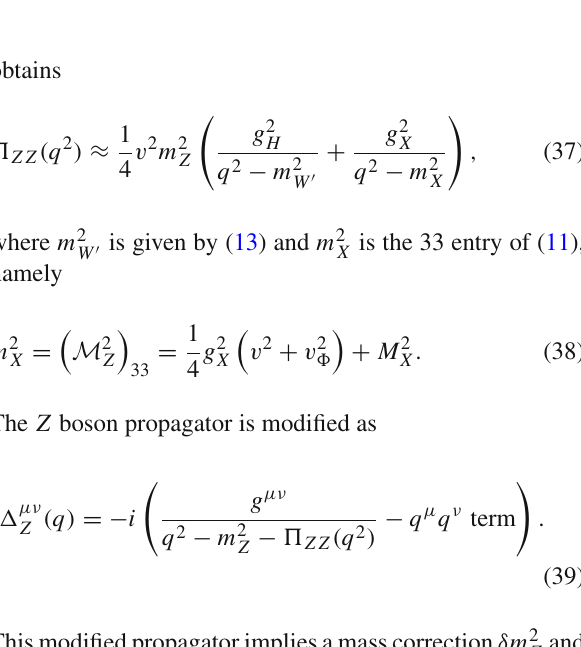
Fig. 2 The W massshiftfromthetreelevelmixingoftheneutralgauge bosons spanned on the ( m W (cid:3) , g H ) plane. Here we set g X = 0. The solid green,solidblueandsolidredlinesrepresentthe W massshiftof1MeV, 20 MeV and the one measured at the CDF II, respectively. The light gray shaded region is the excluded region ( (cid:5) m Z > 2 . 1 MeV) from the measurement of Z boson mass at LEP [58]. The orange region is the excluded region from the di-lepton high mass resonance search from ATLAS